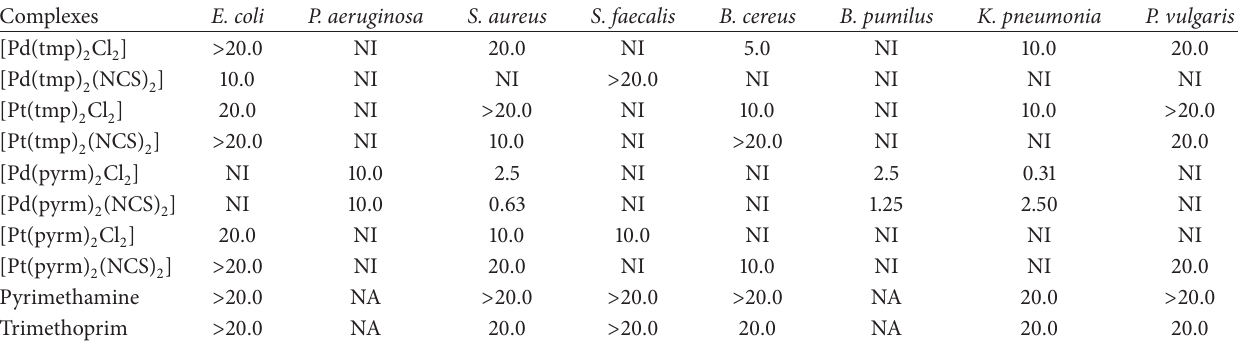
Table 4: MBC values (mg/mL) of the metal complexes on selected bacteria.